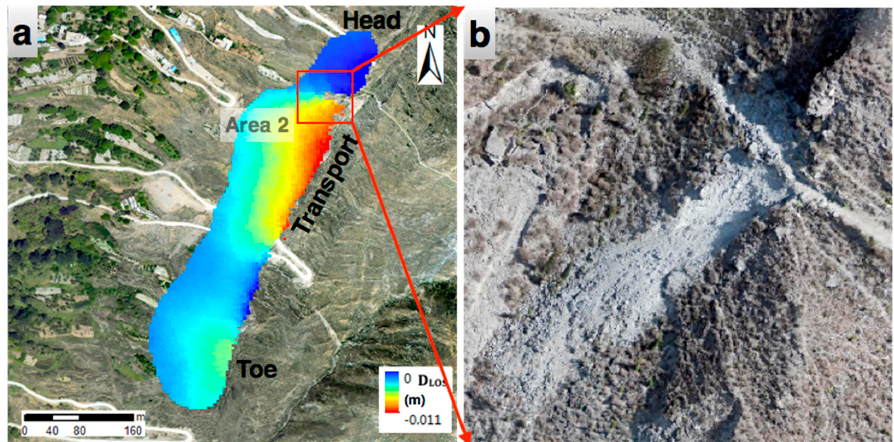
Figure 8. ( a ) An earthflow (Area 2) close to the eastern boundary of the landslide in the lower part. The DInSAR displacements derived from 13 December 2014–15 January 2015 are overlaid. ( b ) The enlarged view of the red square region obtained from the UAV-based high-resolution aerial photo.